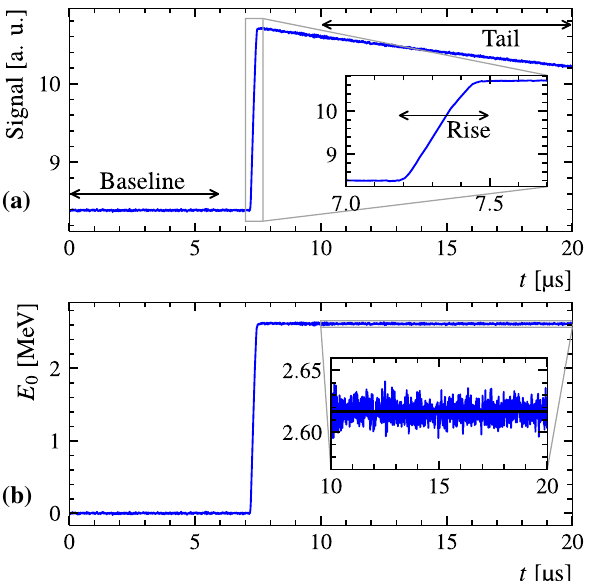
Fig. 8 a Core, E 0 , and b segment 19, E 19 , spectra of the background measurement BG and a typical 241 Am measurement from AST with the top beam-spot at ( ϕ = 257 . 9 ◦ , r = 23 . 8mm) and the side beam- spot at ( ϕ = 167 . 9 ◦ , z = 40 . 0mm). The spectrum of the background measurement is normalised in time to the 241 Am